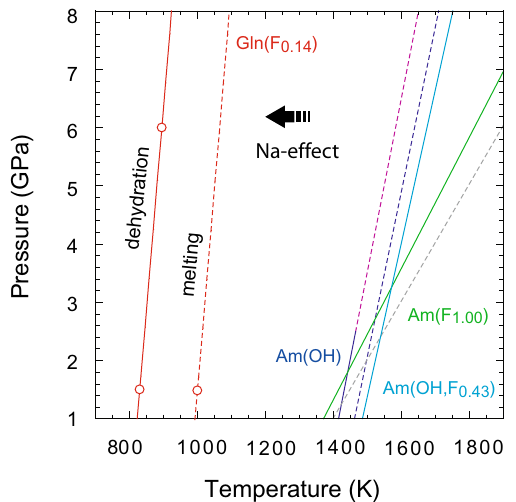
Figure 6. The stability of glaucophane at high-pressure and high-temperature. The solid red line indicates a linear fit through experimental data points obtained at 1.5 and 6 GPa. The red dashed line is drawn parallel to the dehydration curve through the melting temperature obtained at 1.5 GPa. The dark blue, light blue, and green lines are the dehydration and melting temperatures observed for F and Na-free amphibole 29 , Na-free amphibole with 0.43 mol F replacing (OH − ) 28 , and Na-free amphibole with 1 mol F 29 at the pressure range from 3.0 to 5.5 GPa, respectively. am amphibole; gln glaucophane.